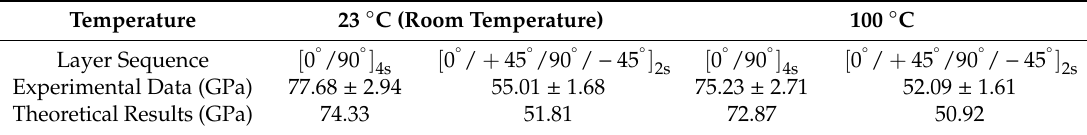
Table 2. Longitudinal moduli study of composite